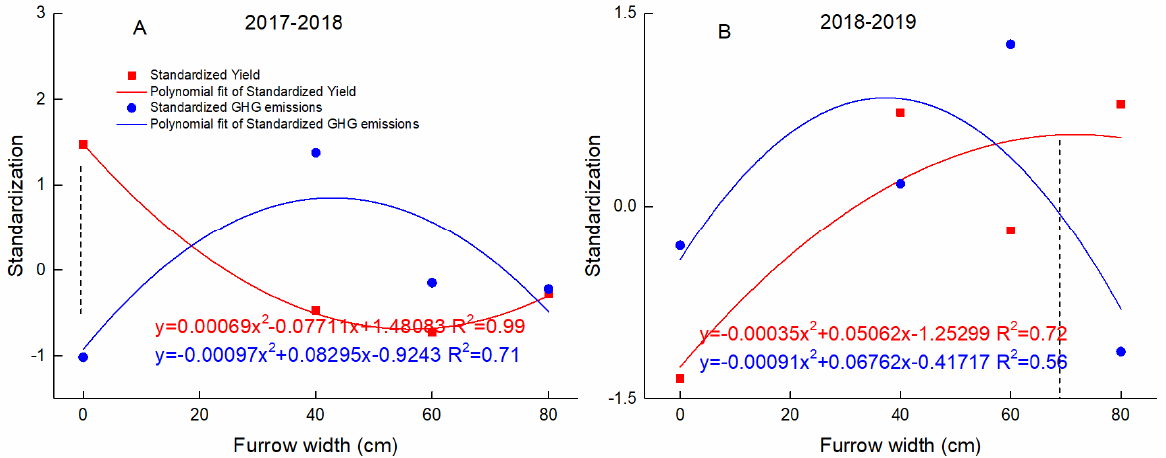
Figure 8. Standardized yield ( A ) and GHG emissions ( B ) of winter wheat as a function of furrow width in CK, RF40, RF60, and RF80 in 2017–2019. The red line is polynomial fit of standardized yield, black line is polynomial fit of standardized GHG emissions.